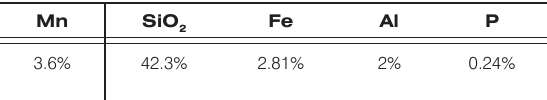
Table 1. The chemical compositions of